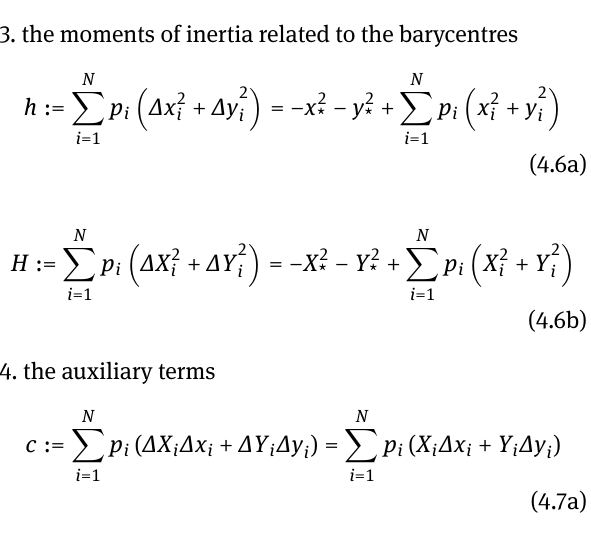
, Y , ϵ , see Fig. 2. Re- 0 0